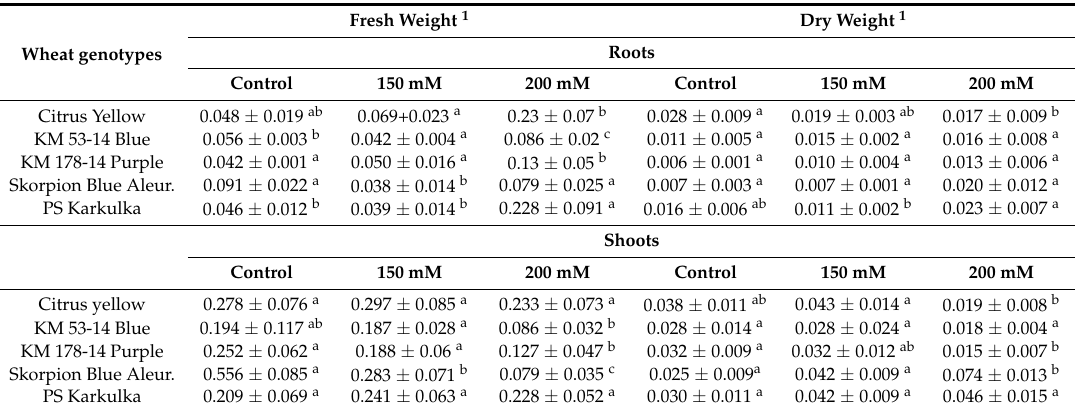
Table 1. Fresh and dry mass after salt stress influence.